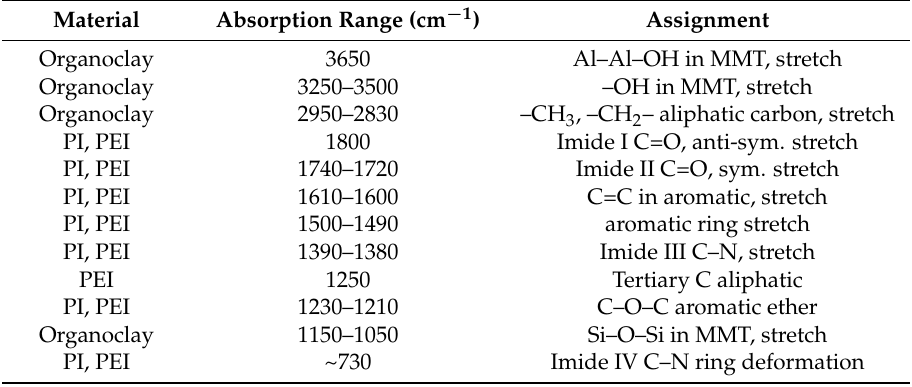
Table 1. FTIR bands assignment for organoclay and coating polymers (PI, PEI) [20,21].